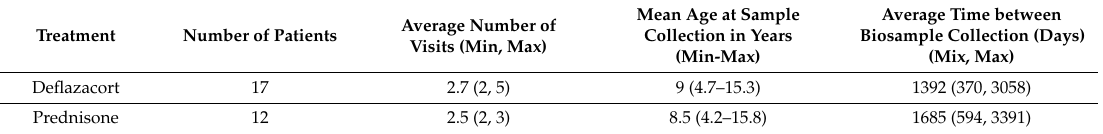
Table 2. Characteristics of patients / samples for confirmation dataset B. These serum samples were used for ELISA confirmation of MMP3, IGFBP-2 and IGF-1. All the samples were from ambulatory patients.